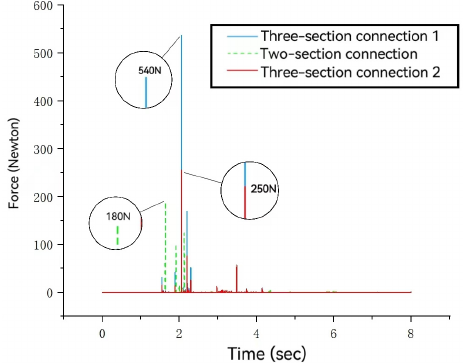
Figure 13 . Force change at the center of the cross. Figure 13. Force change at the center of the